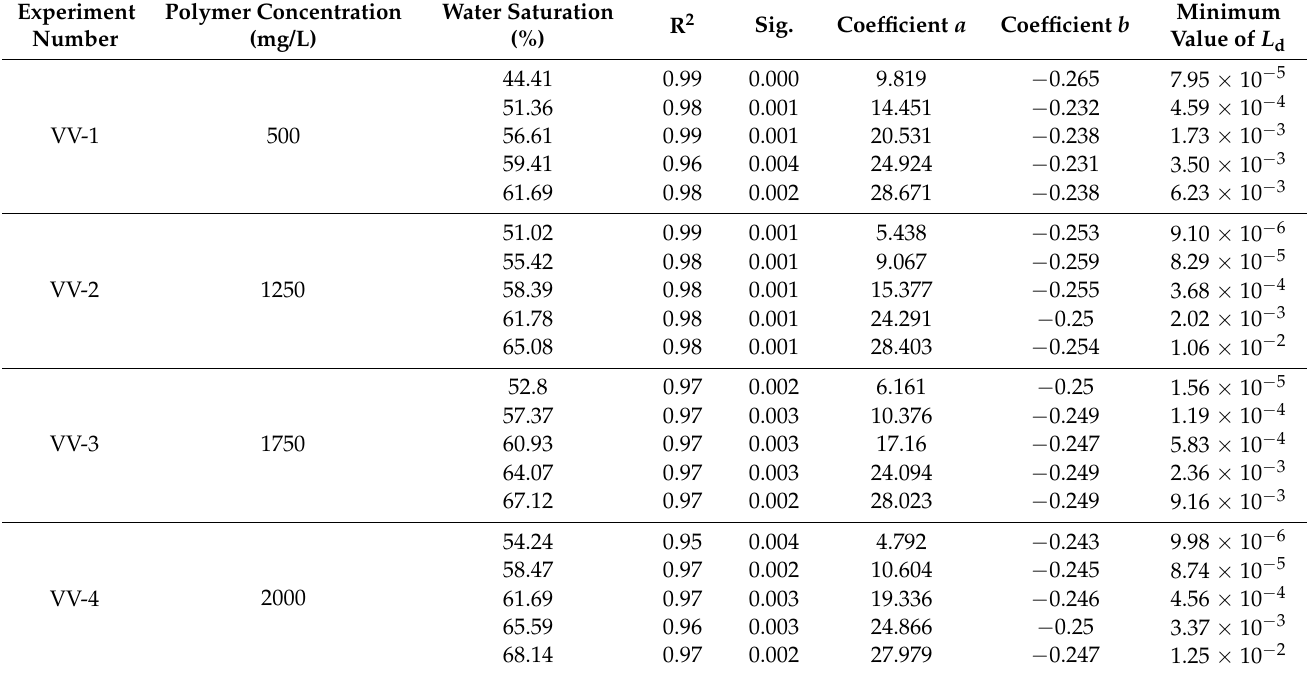
Table 2. Summary, ANOVA and coefficients of Formula (6) (Models are calculated by SPSS).